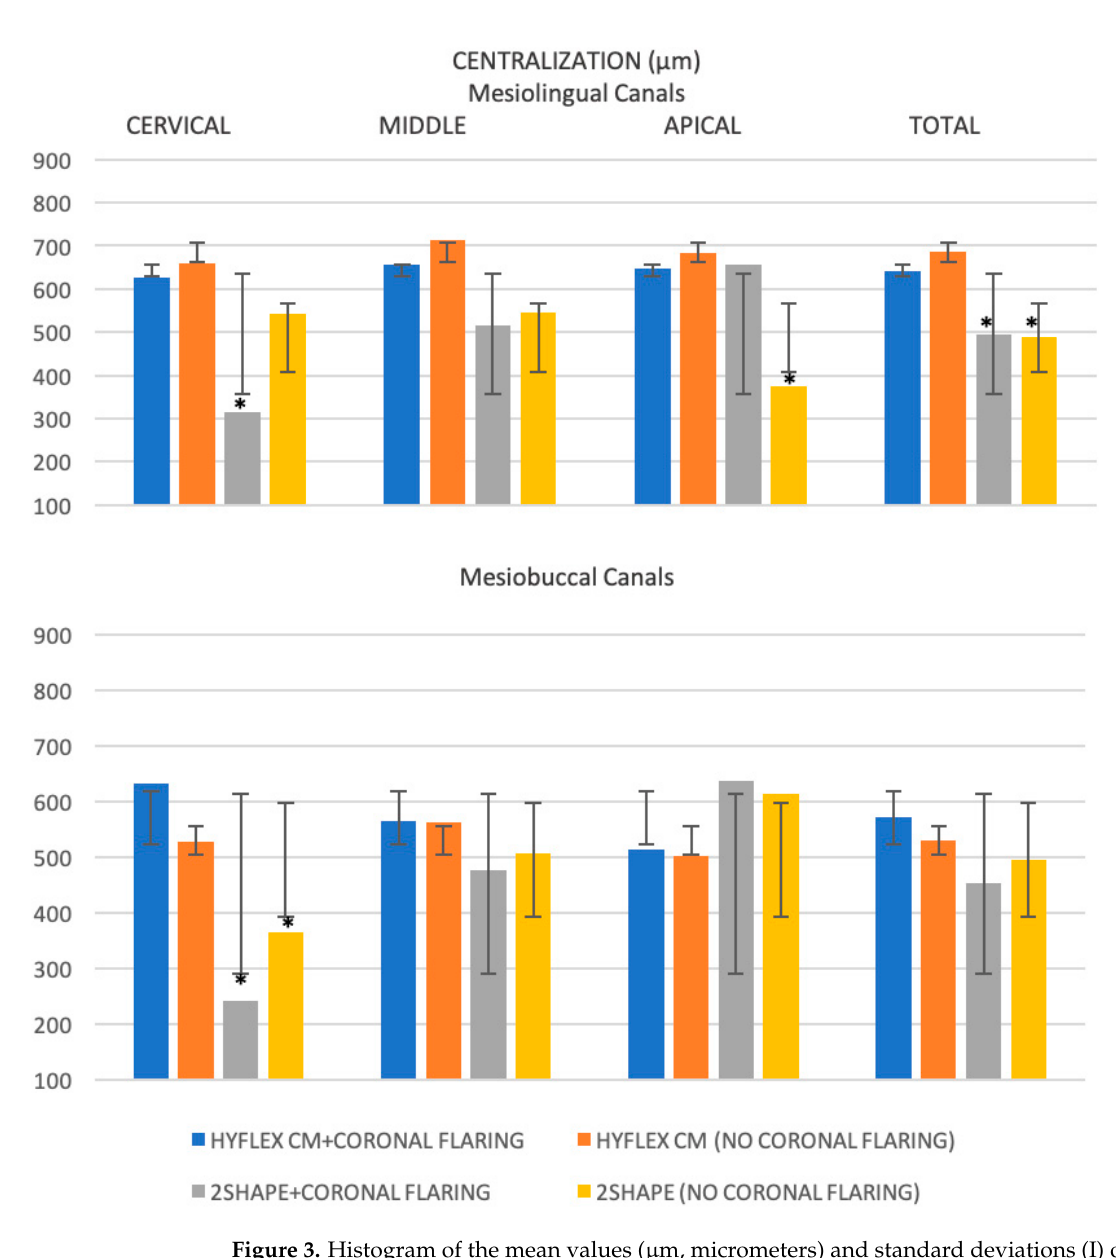
Figure 3. Histogram of the mean values (µm, micrometers) and standard deviations (I) of the root canal centralization for each instrumentation procedure at different anatomical thirds. * indicate a statistically significant difference between the different instrumentation procedures for the same anatomical